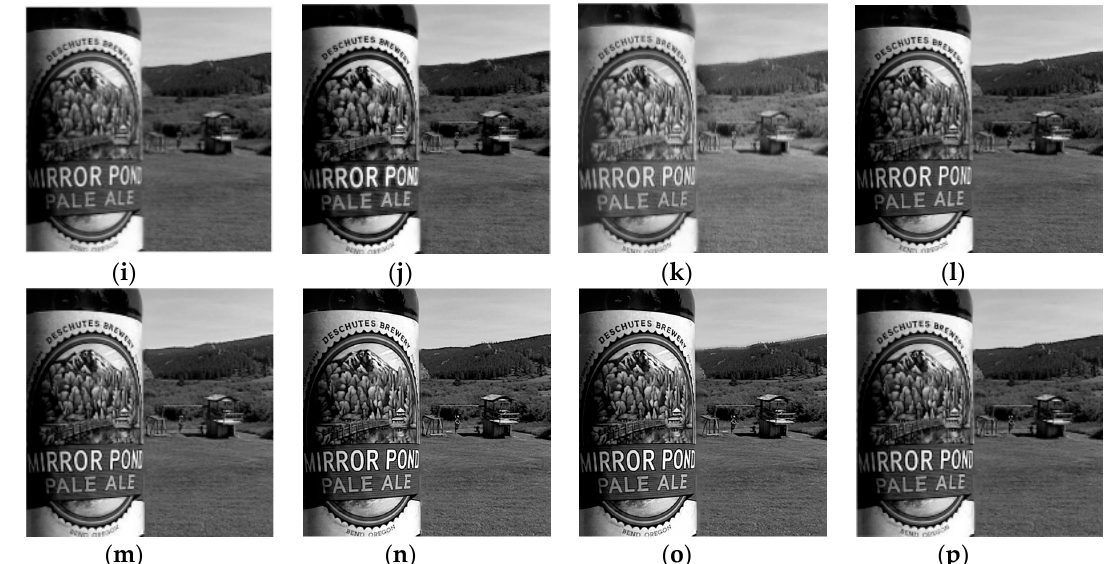
Figure 9. Fused images obtained by different methods in the image pair “wine bottle”. ( a ) PCA; ( b ) SWPCA; ( c ) MWPCA; ( d ) DWT; ( e ) GP; ( f ) MSVD; ( g ) CSR; ( h ) FSD; ( i ) DCHWT; ( j ) MGFF; ( k )